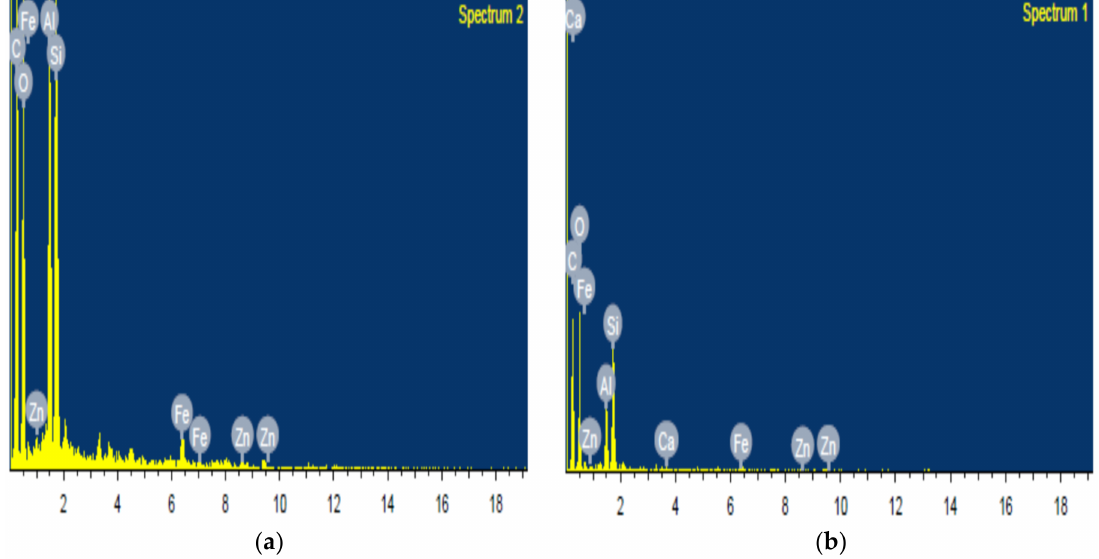
Figure 2. Energy-dispersive X-ray spectroscopy (EDS): ( a ) fly ash and ( b )